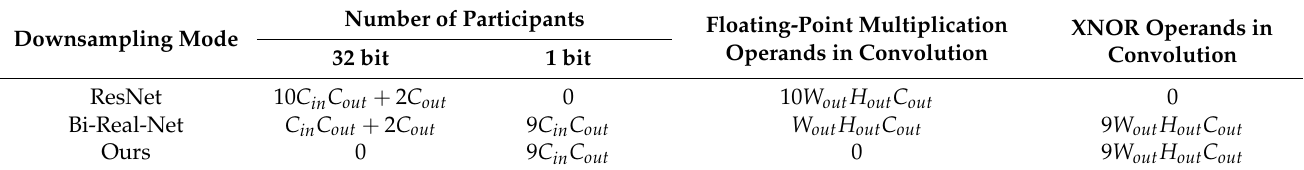
Table 2. Comparison of number of parameters and calculation values of different descending sampling